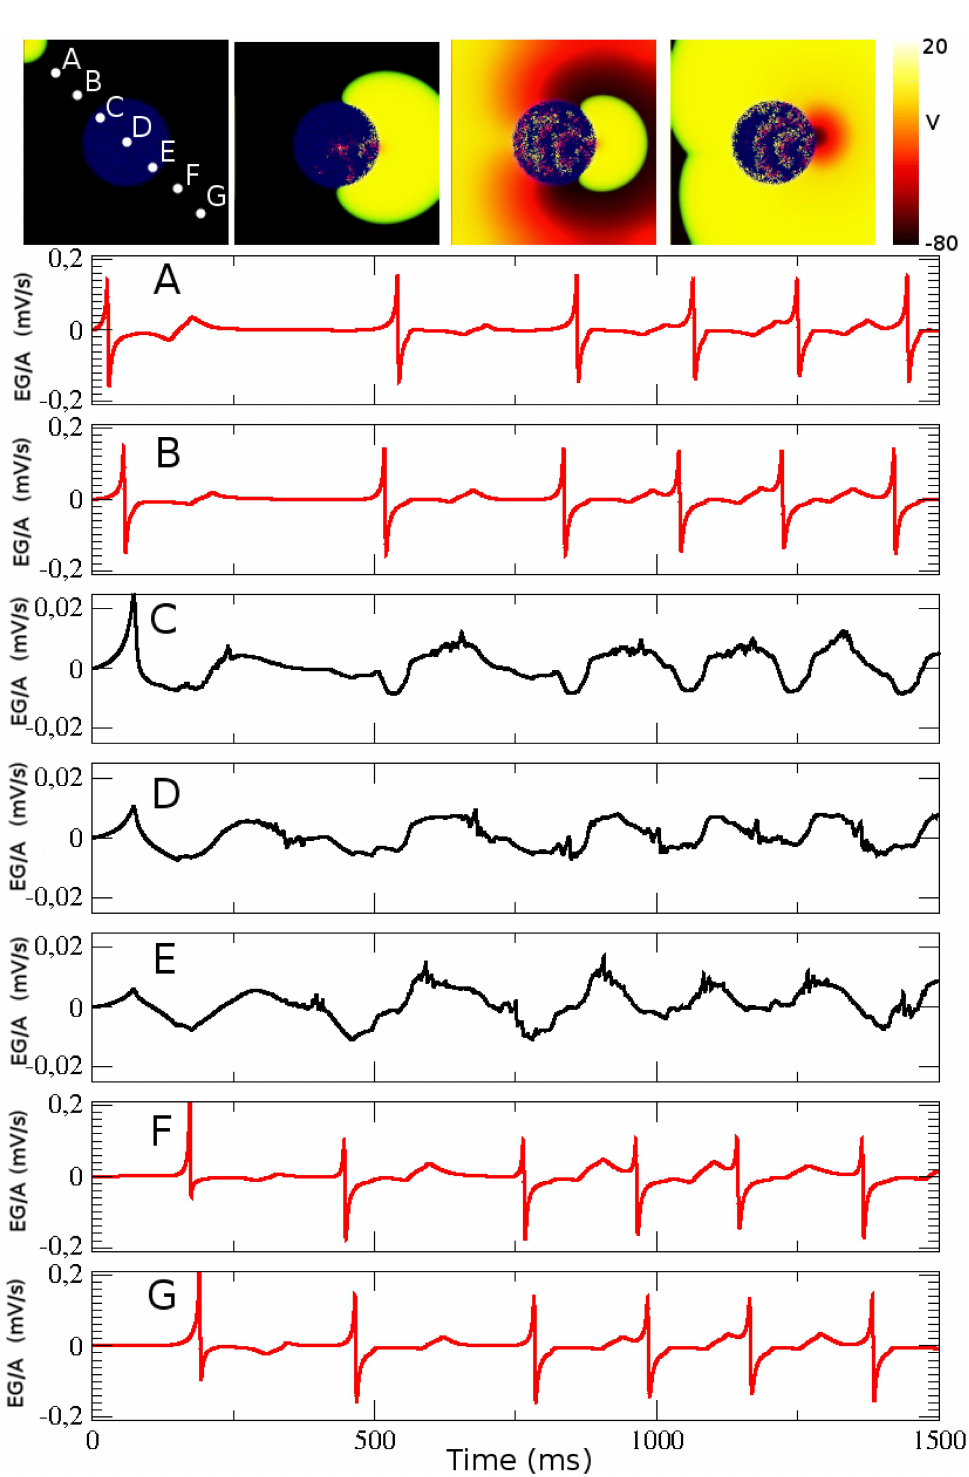
Fig 8. Electrogramsat different locations in the tissue during reentry. The signals of different electrodesare plotted in arbitrary units for a numerical simulationshowingreentry. Four snapshotof the top view of the tissue slab for times t = 16.5 ms , t = 500 ms , t = 1000 ms , and t = 1500 ms . The location of the electrodesis shown in the first snapshotby white circles. The electrodes are locatedat 0.01 cm from the slab of tissue. Signals calculatedin each electrode, followingEq (6), are plotted. Black and red curves correspond to electrodesinside and outsideof